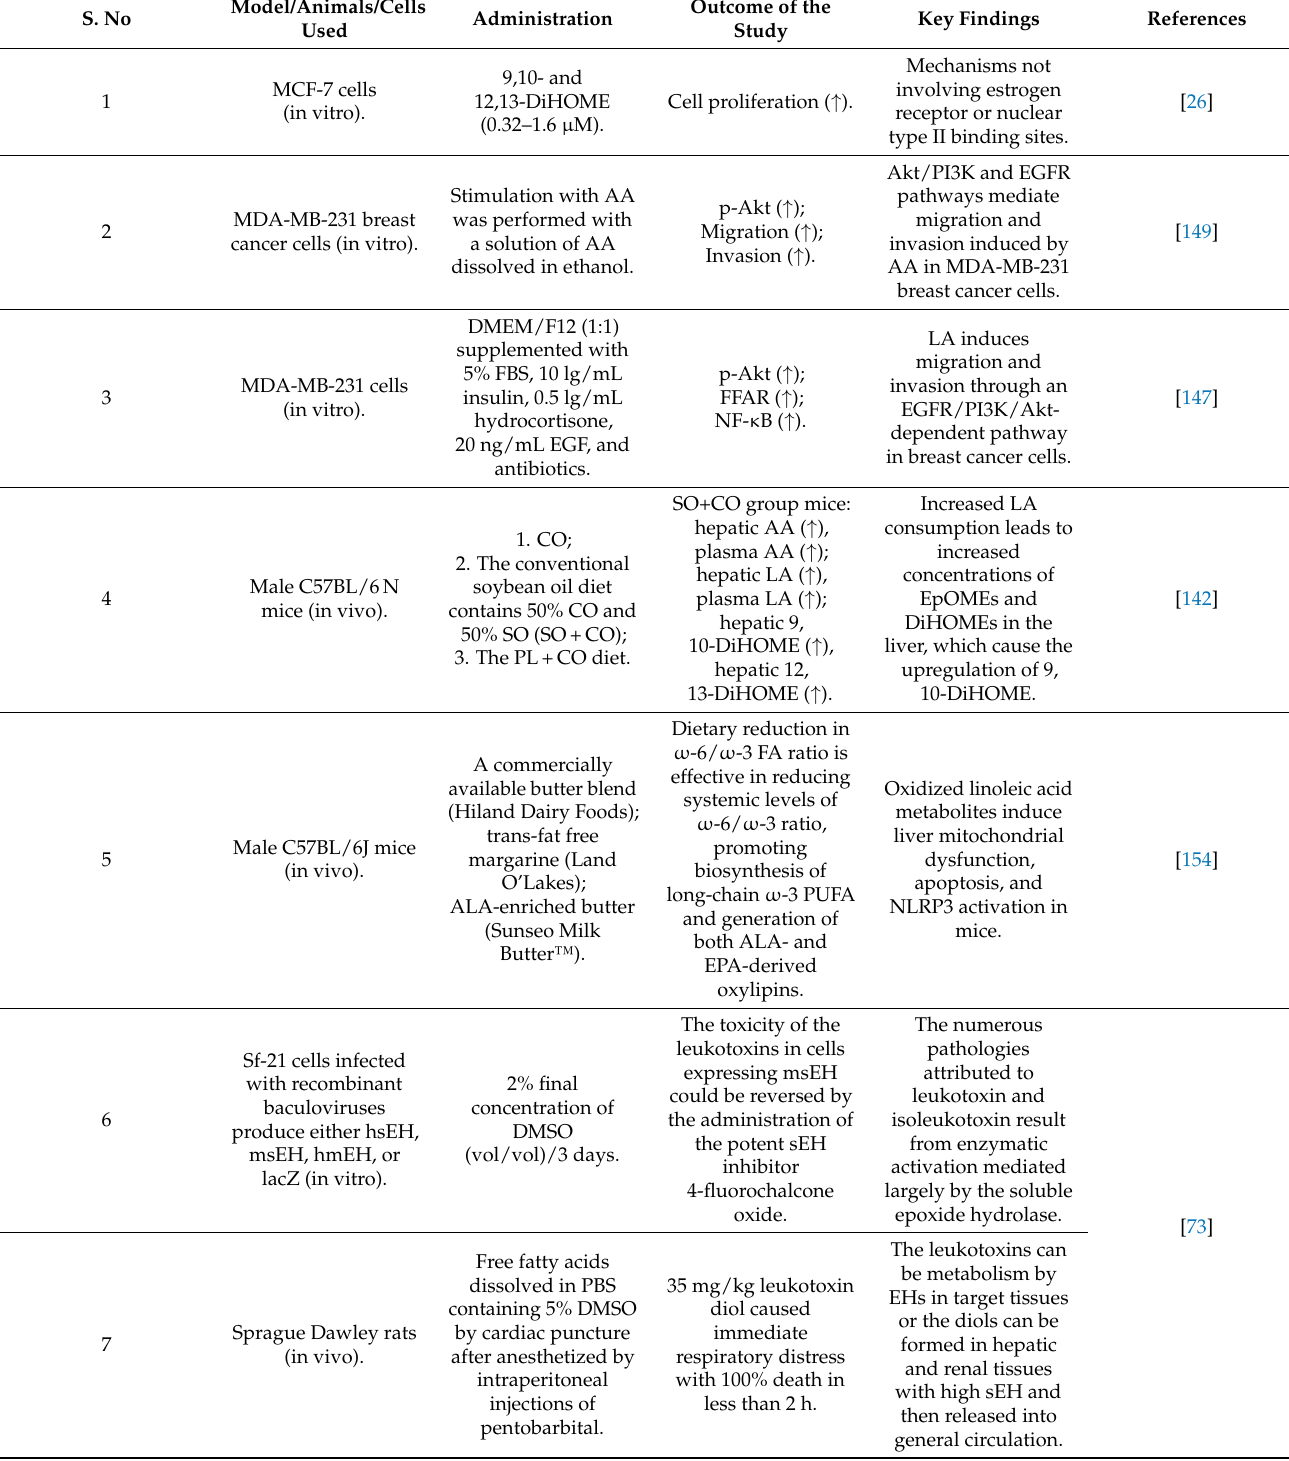
Table 3. Association between hepatic sEH and breast cancer based on the preclinical